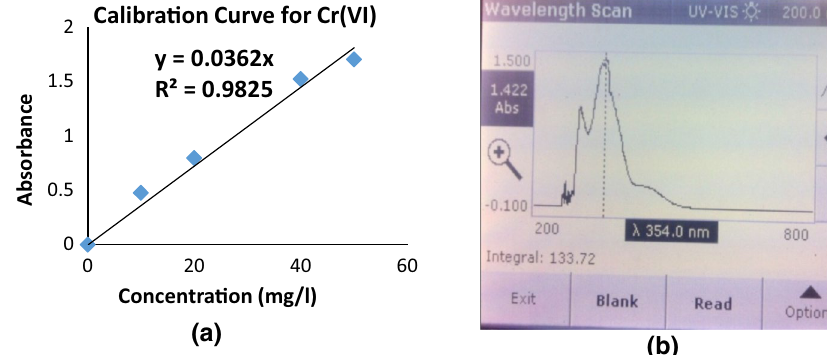
Fig. 3 a Calibration curve of Cr(VI), b UV–visible spectrum of Cr(V) y = 0.0362x